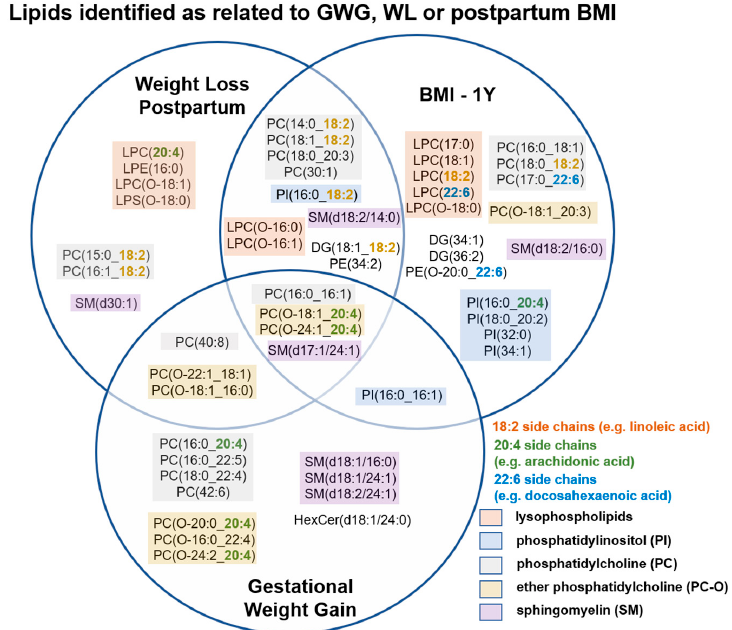
Figure 2. The Venn diagram shows blood lipids associated to GWG, WL or 1Y BMI in the